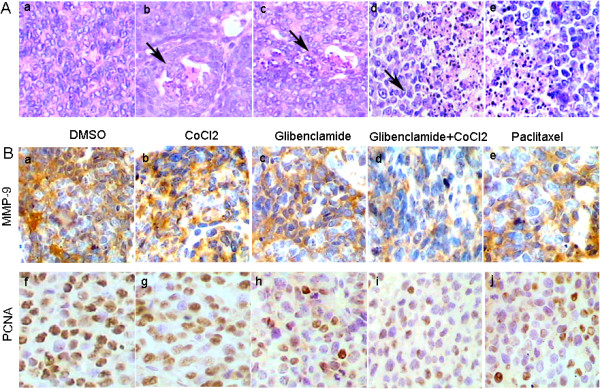
The differences of morphology, MMP9 and PCNA expression of TA2 breast cancer between the control and treatment groups. A. The morphologic characteristics of TA2 breast cancer in the control and treatment groups (HE staining, ×200). a. DMSO group. b. CoCl2 group. c. Glibenclamide group. d. CoCl2 + glibenclamide group. e. Paclitaxel group. B. Immunohistochemical staining for MMP9 and PCNA in the control and treatment groups (immunohistochemical staining, ×200). a. MMP9 staining of DMSO group. b. MMP9 staining of CoCl2 group. c. MMP9 staining of Glibenclamide group. d. MMP9 staining of CoCl2 + glibenclamide group. e. MMP9 staining of paclitaxel group. f. PCNA staining of DMSO group. g. PCNA staining of CoCl2 group. h. PCNA staining of Glibenclamide group. i. PCNA staining of CoCl2 + glibenclamide group. j. PCNA staining of paclitaxel group.